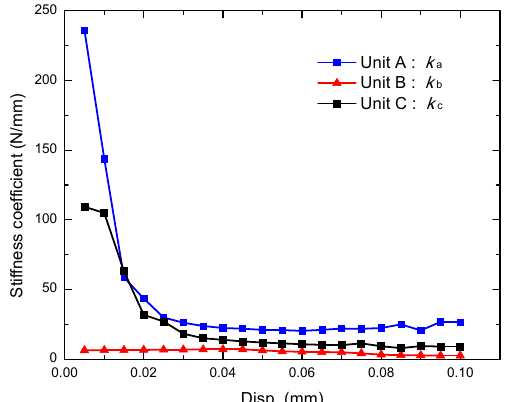
Figure 8. Displacement-dependent stiffness coefficients, k a , k b, and k c , of the single unit of Patterns A, B, and C,